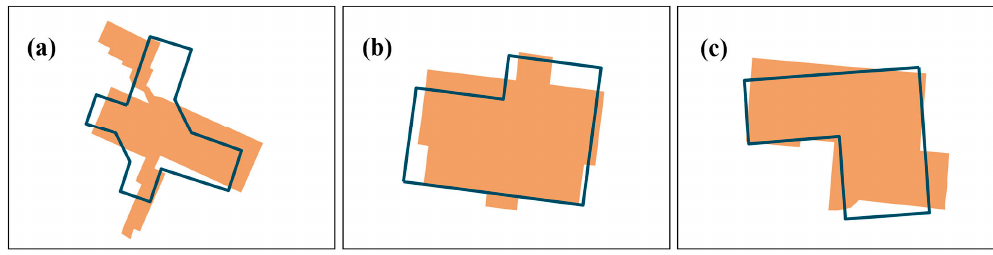
Figure 9. Example for each type of error: ( a ) the first type of error, ( b ) the second type of error, and ( c ) the third type of error.